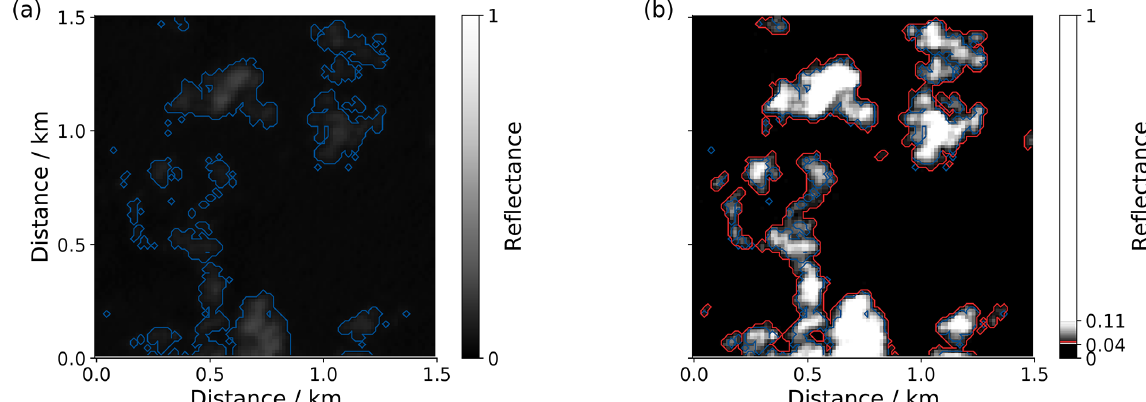
Figure 5. Visualization of the area corresponding to optically thin clouds. Shown are reflectances at 0.807µm for a 1 . 5 × 1 . 5km 2 selection of an ASTER image recorded on 5 February 2020 at 14:25:15UTC. (a) The full physical range of reflectance values ranging from 0 to 1 with overlaid blue contours outlining the ASTER cloud mask. (b) Similar to (a) but with the color scale limited to the 10th and 90th percentile of reflectances attributed to total cloud cover including optically thin clouds. The red contours correspond to p ( F TOTAL_CLOUD | R = R pixel ) ≥ 0 . 9.